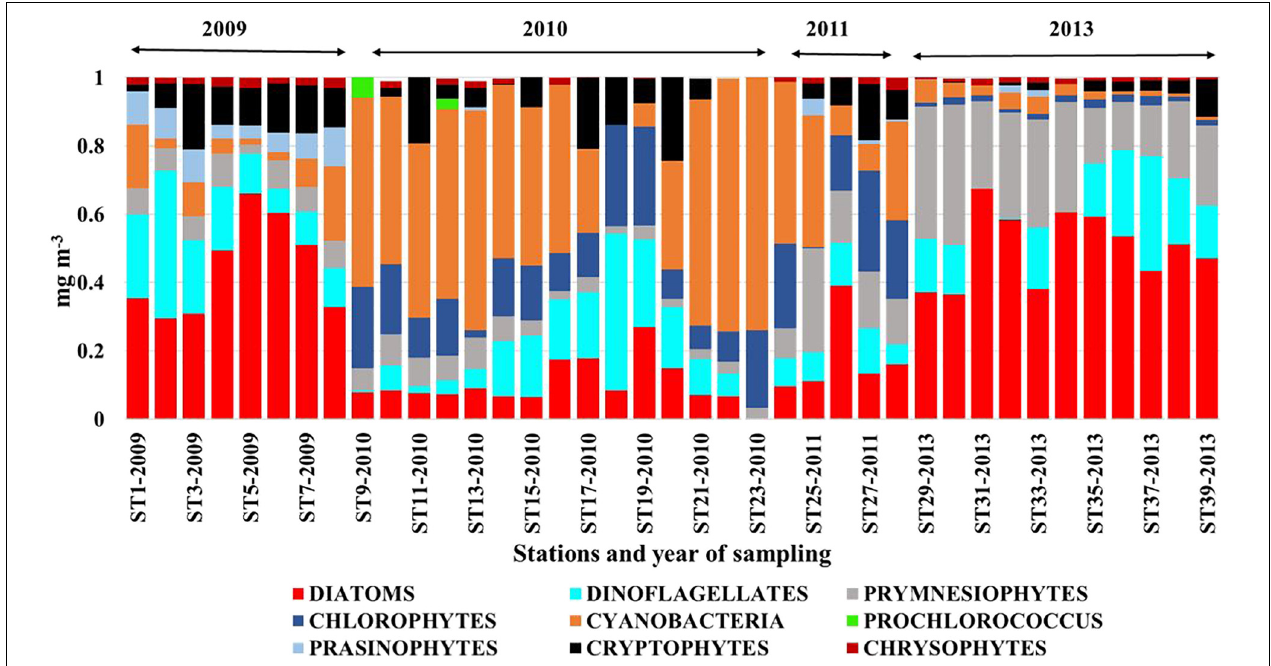
FIGURE 6 | Phytoplankton classes derived by pigment analysis and CHEMTAX in the CDW in 2009, 2010, 2011, and 2013. plot. Redrawn from Xu et al.